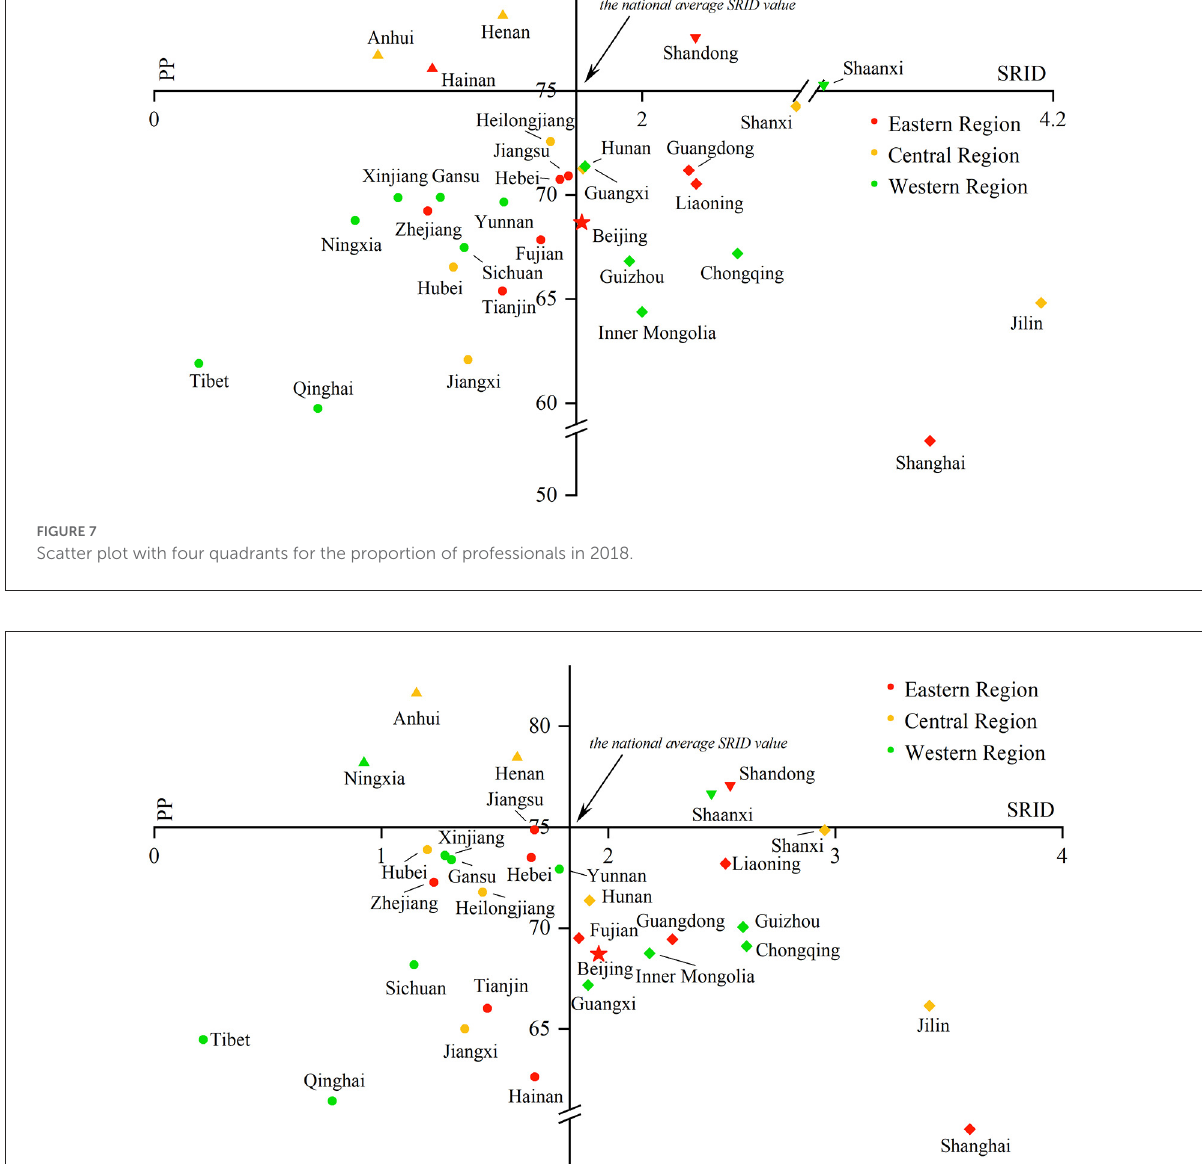
drawn using Origin 2018 software. The four quadrants have